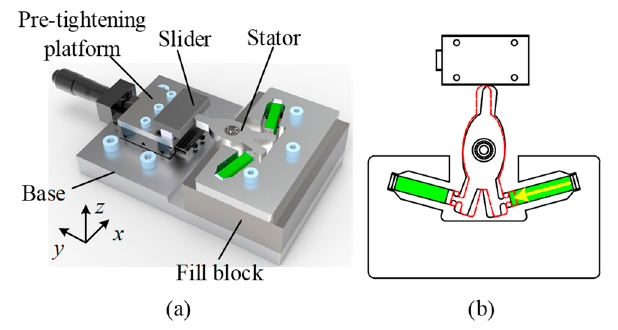
Figure 8. ( a ) Model of the improved actuator with one driving foot, and ( b ) deformation diagram of the stator.